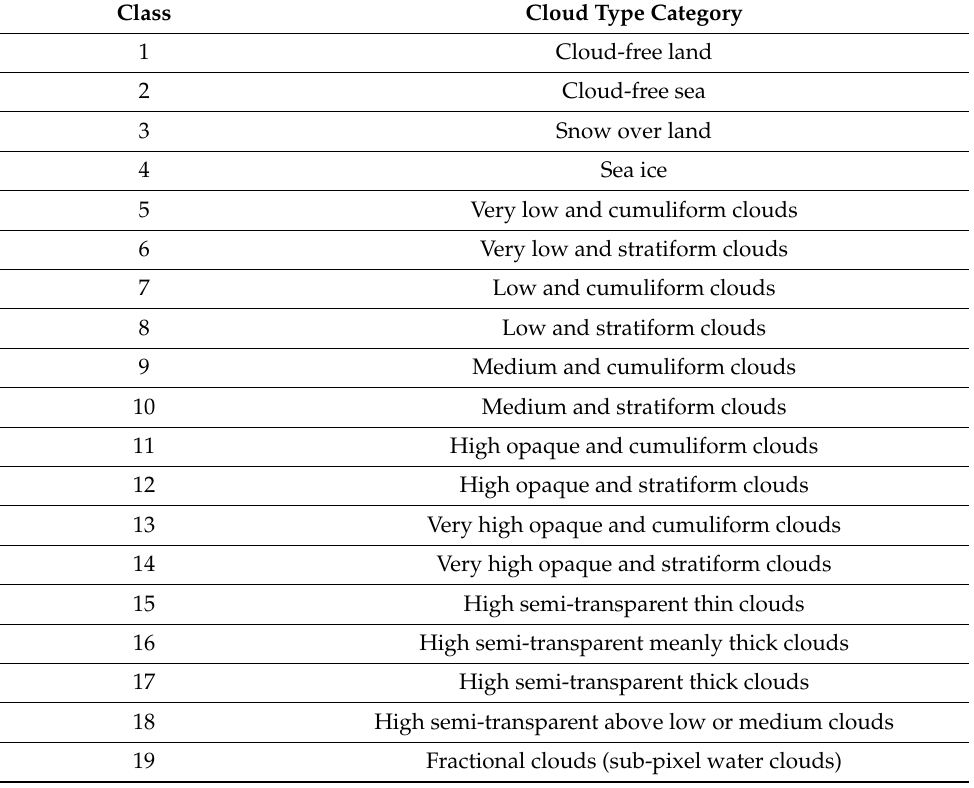
Table 2. Cloud type classification of the SAFGEO